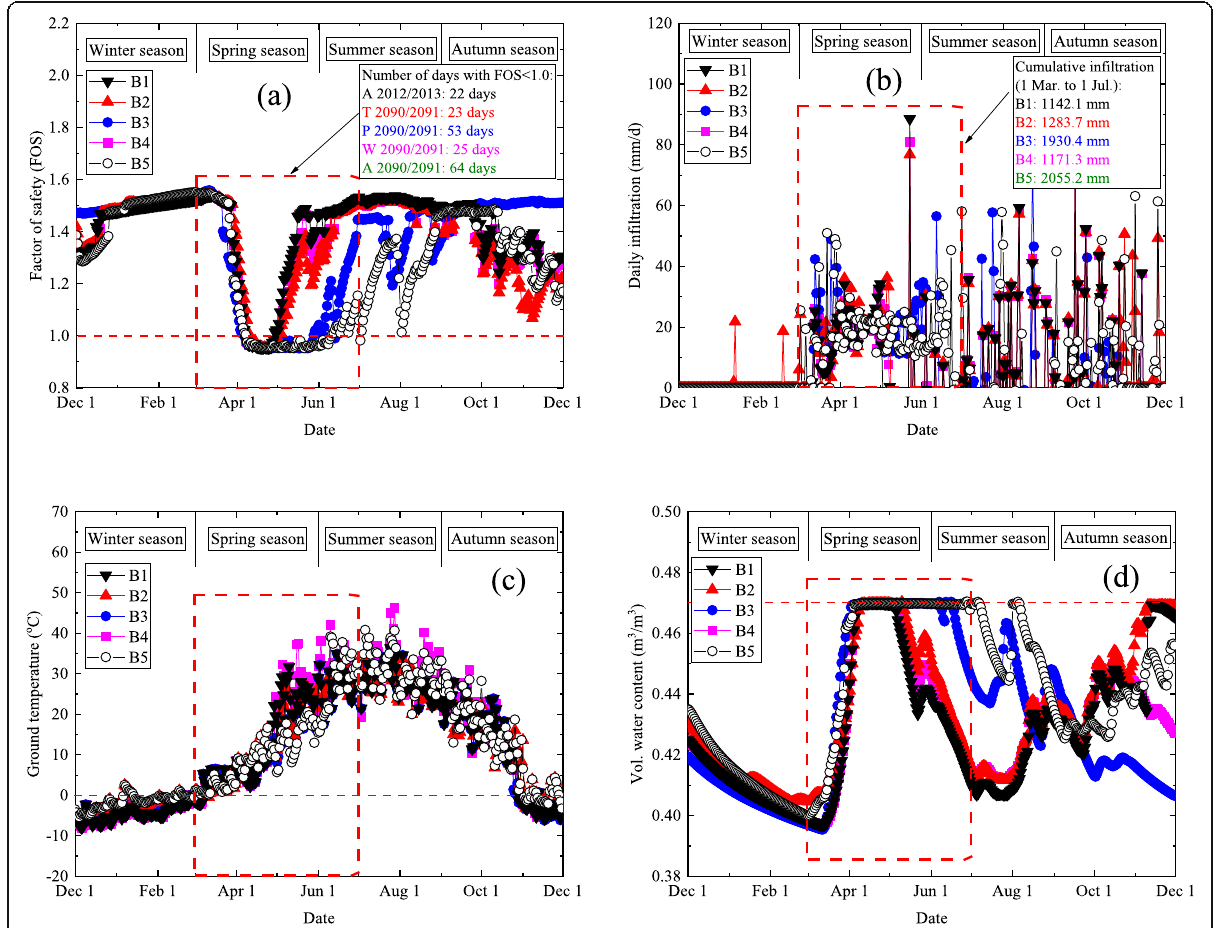
Fig. 13 Simulation results of ( a ) FOS vs. time, ( b ) Daily infiltration vs. time, ( c ) Ground surface temperature vs. time, and ( d ) Vol. water content vs. time (the red dash line is saturated vol. water